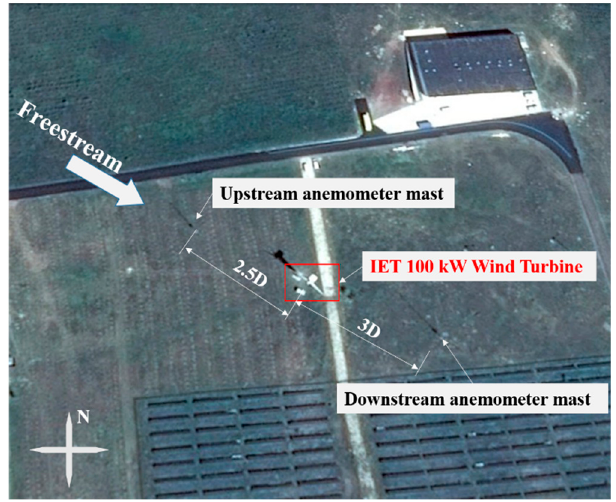
Figure 1. Google map of the wind farm.